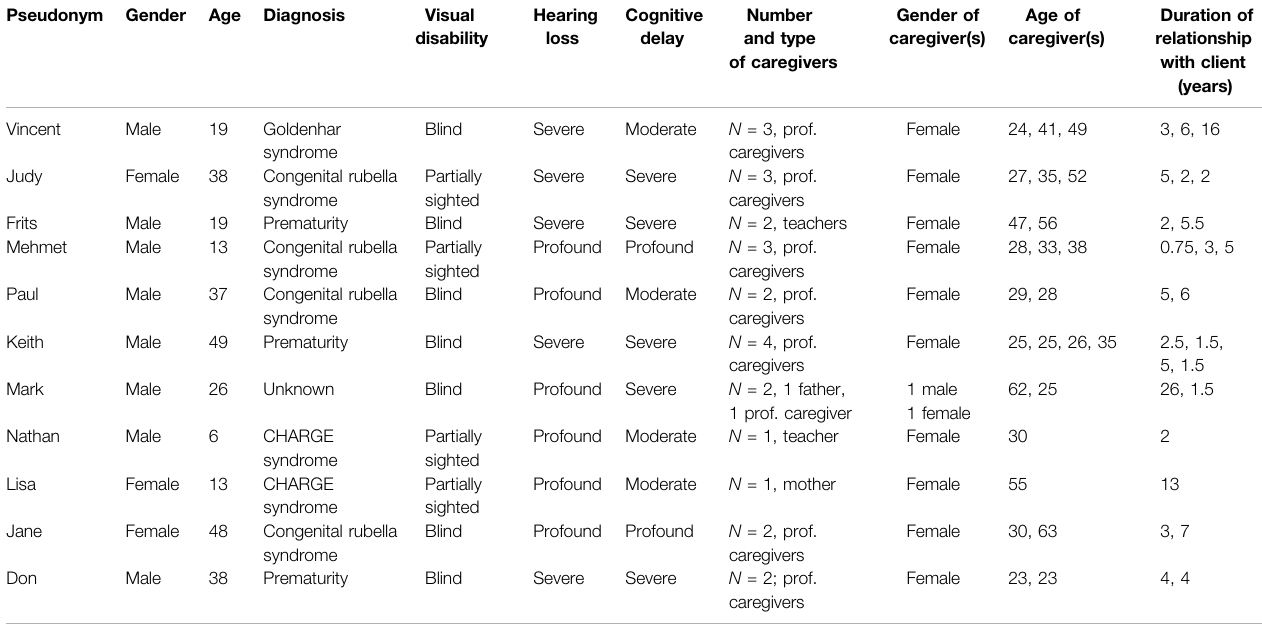
TABLE 1 | Characteristics of 11 participants with multiple disabilities. Pseudonym Gender Age